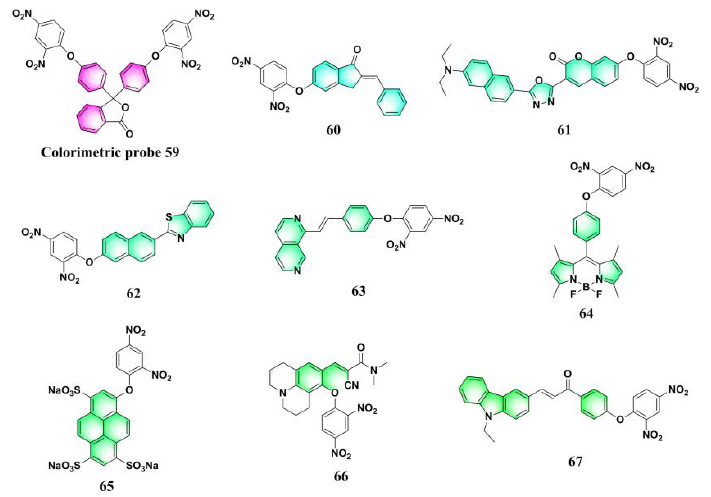
Figure 25. Structures of PhSH probes ( 59–67 ).